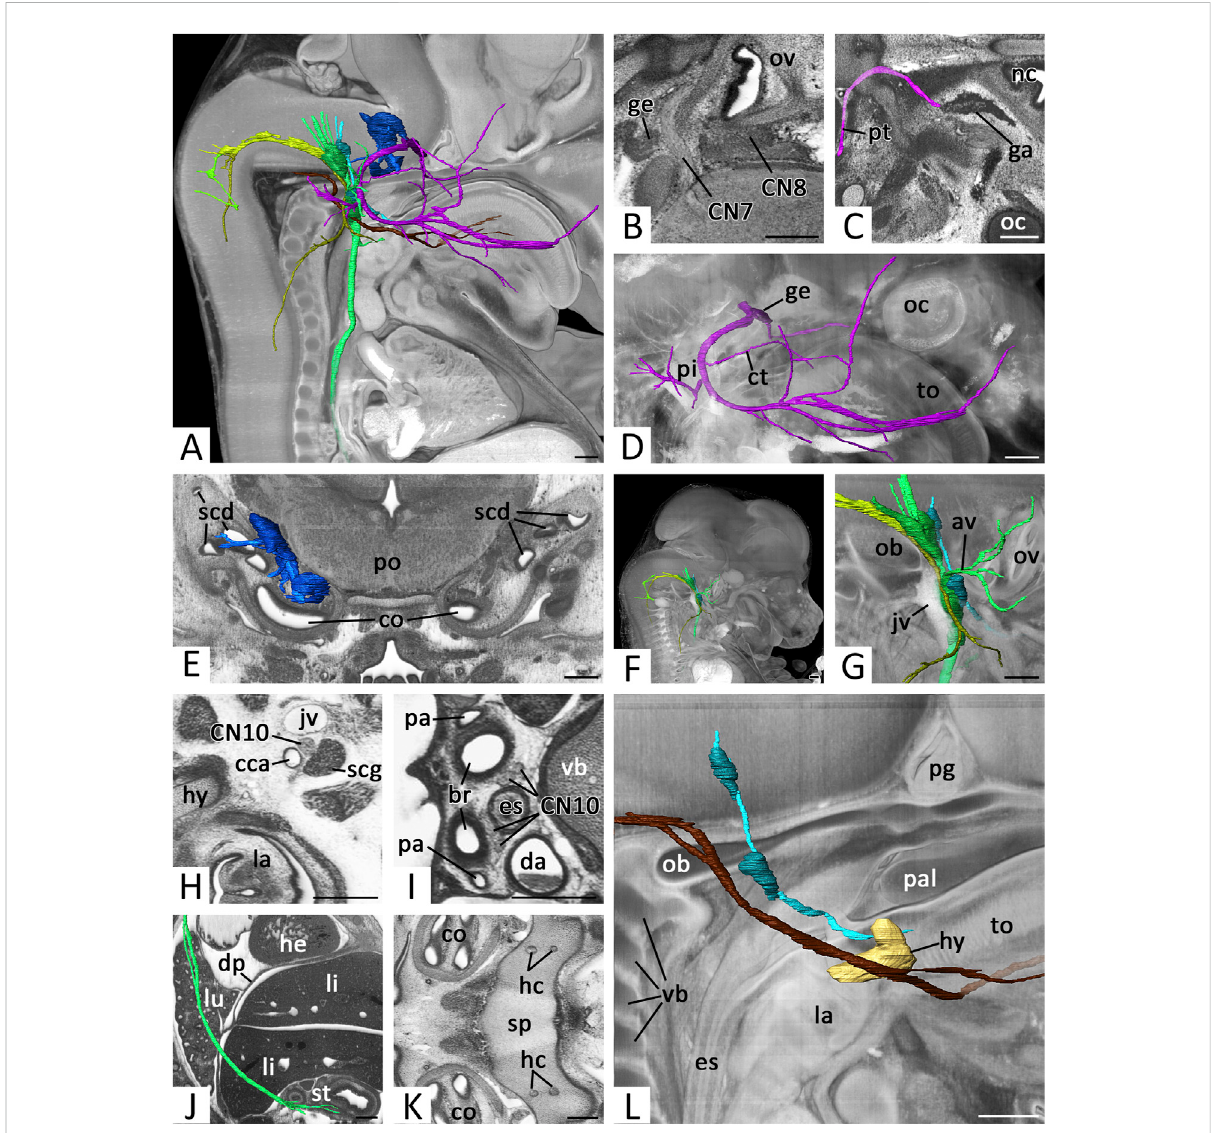
FIGURE 6 Cranialnerves(CN)7to12: (A) OverviewofrightCNs7,8,9,10,11and12.3Dsurfacerenderingsinthecontextofavolumerenderingofamouse embryo of S23. View from right. CN6 (pink), CN7 (violet), geniculate ganglion (dark violet), CN8 (blue), ganglia CN8 (dark blue), CN9 (turquoise), gangliaofCN9(darkturquoise),CN10(green),gangliaofCN10(darkgreen)CN11(olive),cranialrootCN11(lightgreen),CN12(brown) (B) Exitofright CN7 and CN8 in an axio-frontal HREM resection. Anterior to the left, right on top (C) Right greater petrosal nerve (pt) (pink) reaching the ganglion mass in thepterygopalatine fossa (ga). Surface renderings in thecontext of an axial HREM section. Anterior to the right, left on top (D) Right facialnerve(CN7)(violet)withgeniculateganglion(ge)(darkviolet).Surfacerenderingsinthecontextofavolumerendering.Viewfromright (E) Right vestibulocochlear nerve (CN8) (blue) and its ganglia (dark blue). Surface renderings in the context of frontal HREM resection (F,G) Right CNs 9 (turquoise),10(green)and11(olive)passingthroughthejugularforamen.Surfacerenderingsinthecontextofavolumerendering.Viewfromright (G) Shows magni fi cation from (F) . Note the superior and inferior ganglia (dark turquoise, dark green) and the topology of the jugular vein (jv) (H – J) Courseoftherightvagusnerve(CN10)(green).AxialHREMsections,anteriortotheleftandrightontop (H,I) andsurfacerenderinginthecontextofa sagittal resection, anterior to the right. (H) Cervical CN10 between common carotid artery (cca), jugular vein and superior cervical sympathetic ganglion (scg). (I) Thoracic CN10s lateral to the esophagus (es) (J) Thoracic and abdominal CN10 (green) reaching the stomach (st) (K) Hypoglossal canals (hc)inthesphenoid bone(sp).AxialHREM section. Anterior totheleft,rightontop (L) Right CNs 9(turquoise) and12 (brown) inthecontextof theforminghyoidbone(hy)(lightbrown)reachingthetongue(to).Surfacerenderingsinthecontextofavolumerendering.Viewfromright.Abr.av= auricular branches ofvagus nerve,br =bronchus,co=cochlea,ct =chordatympani, da=descendingaorta, dp=diaphragm,he=heart, la=larynx, li=liver,lu=lung,nc=nasalcavity,ob=occipitalbone,oc=opticcup,ov=oticvesicle,pa=pulmonaryartery,pal=palate,pg=pituitarygland,pi= pinna, po = pons, scd = semicircular duct, vb = vertebral body. Scale bars = 250